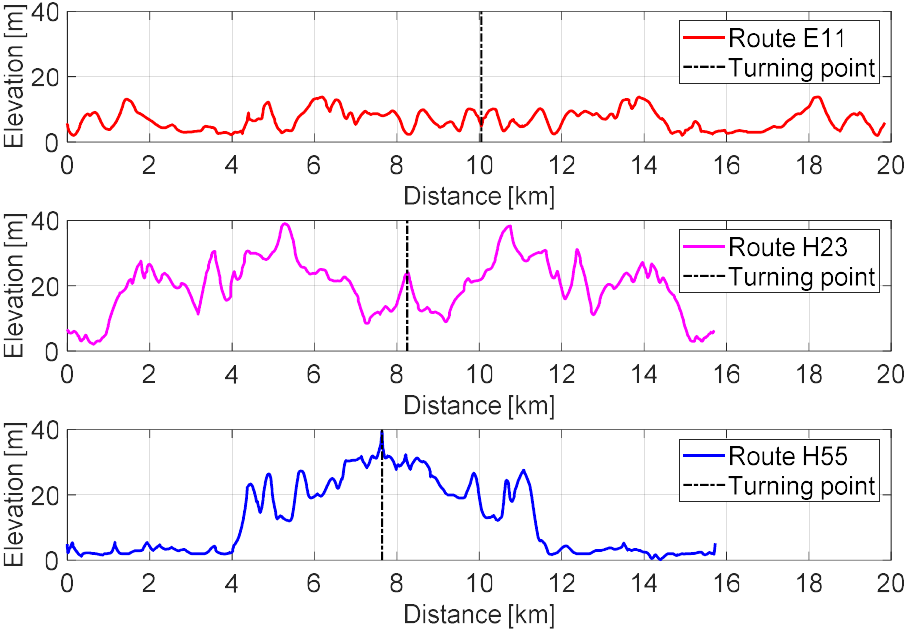
Figure 11. Elevation profiles of the E11, H23, and H55 bus routes.